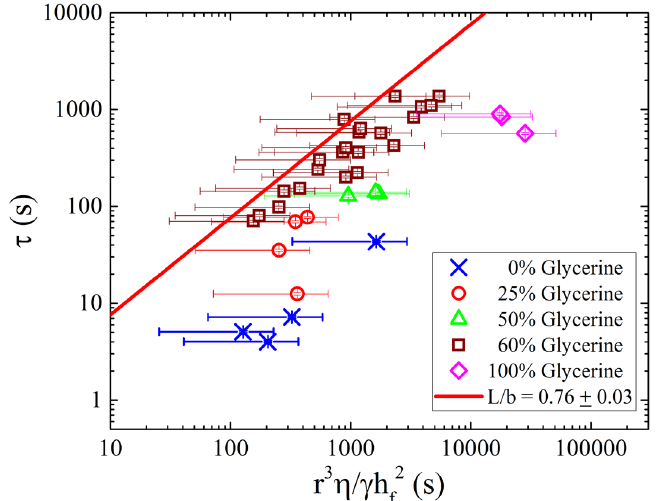
Figure 6. Experimentally extracted time constants of draining drops in a range of outer fluid viscosities. A linear least squares fit yields a value of 0.76 ± 0.03 for L / b . The viscosities used for 0, 25, 50, 60, and 100 percent glycerine solutions were 0.00101, 0.0024, 0.006, 0.0108, 1.412 Pa . s , respectively. Error bars are estimated from measured quantities.